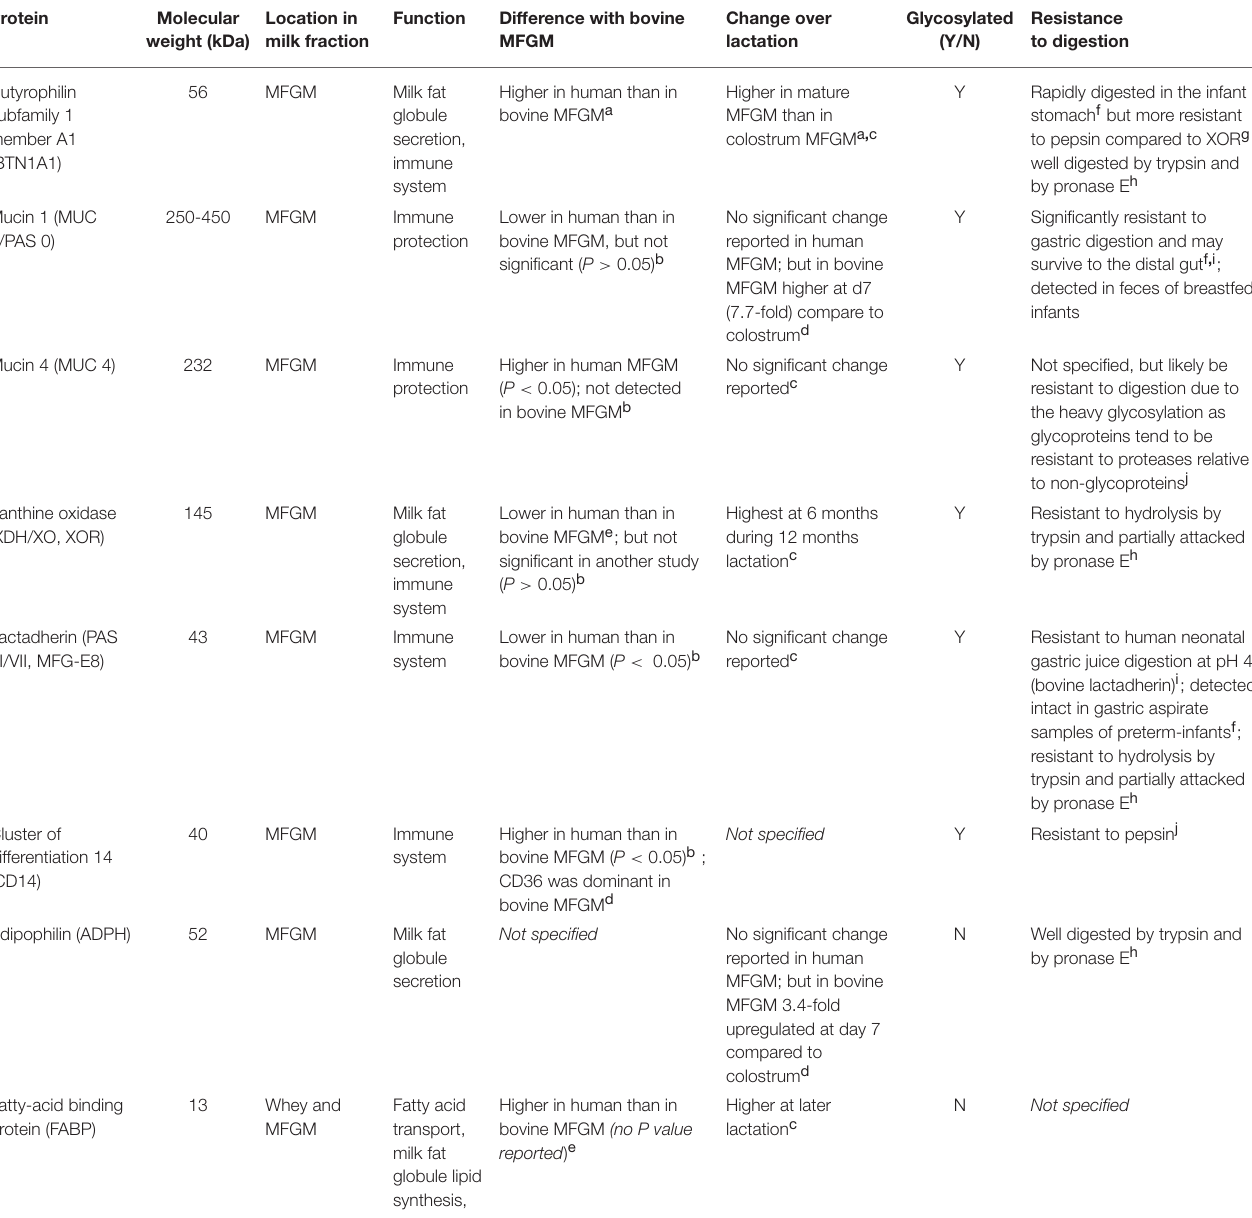
TABLE 2 | Properties of major human milk fat globule membrane (MFGM) proteins. Protein Molecular Location in Function Difference with bovine weight (kDa) milk fraction